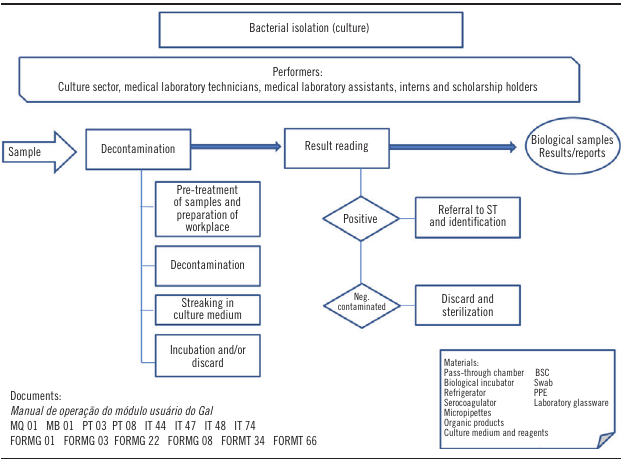
figurE 5 – Flow chart of bacterial isolation (culture) assay ST: sensitivity test; BSC: biological safety cabinet; PPE: personal protection equipment.